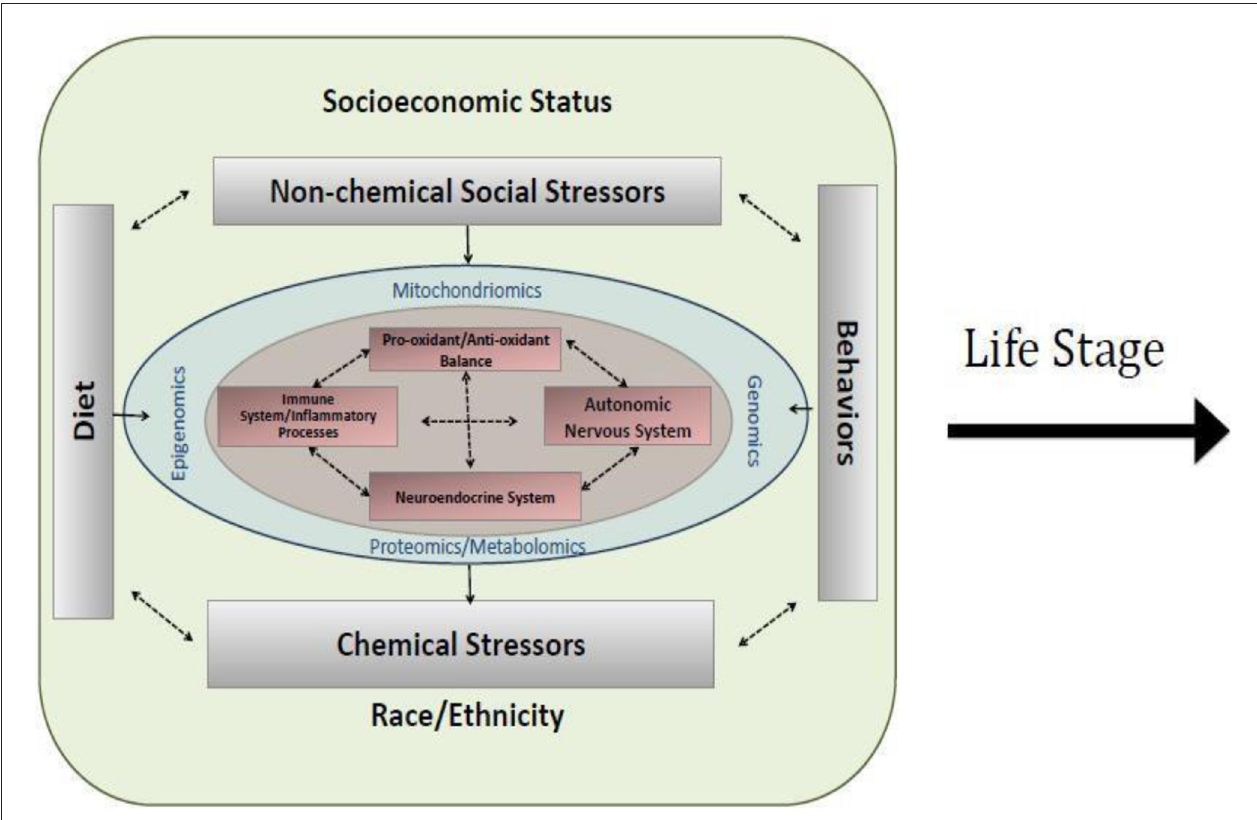
FIGURE 2 | Conceptualization of a cross-section of the exposome within a life stage interval. Socioeconomic status, non-chemical stressors, race/ethnicity, chemical stressors, diet, and behavior interact with genomics, epigenomics, mitochondiomics, and proteomics/metabolomics to influence healthy biological functioning, including oxidant/antioxidant balance, autonomic nervous system, inflammation, and neuroendocrine